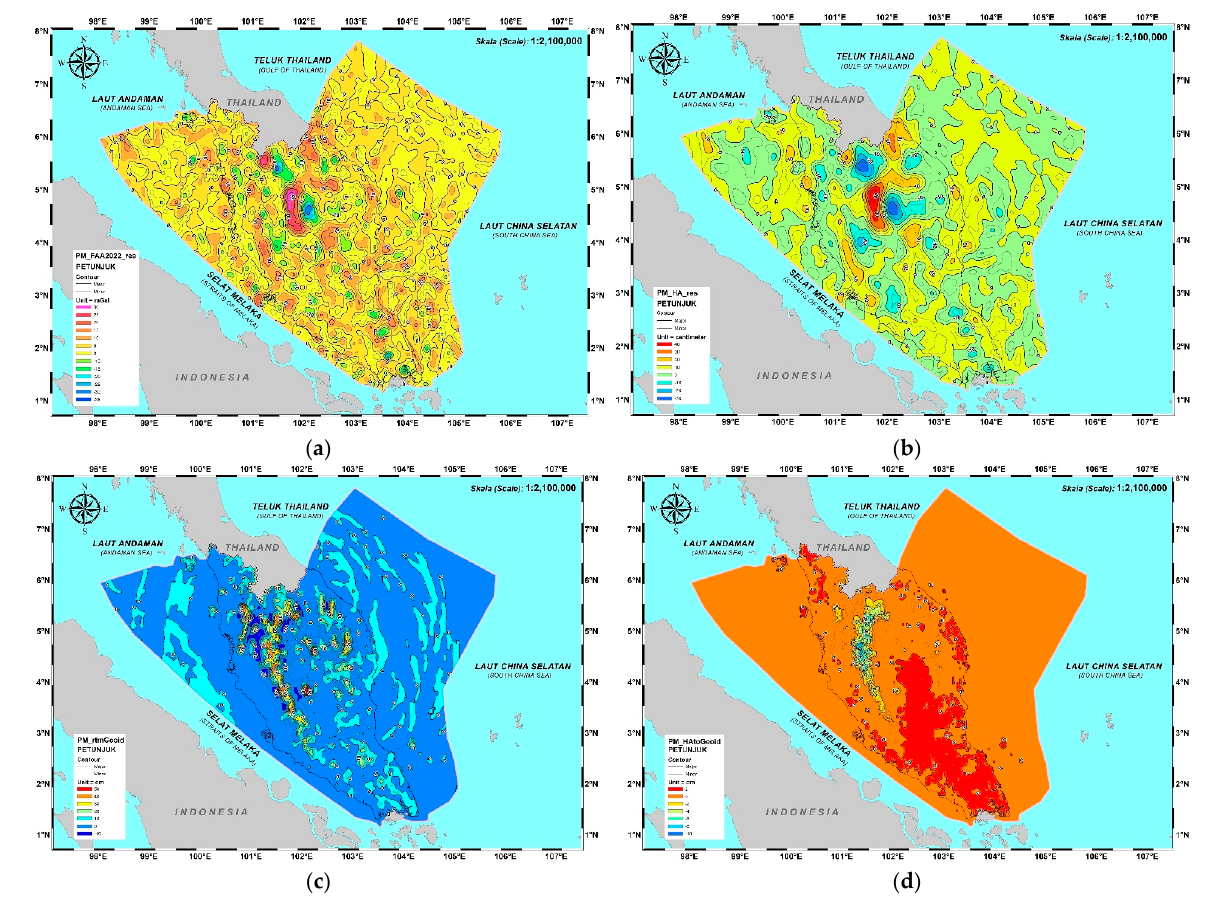
Figure 12. ( a ) Gridded downward continued residual of free-air anomalies, where the contour interval (CI) is 5 mGal; ( b ) Gridded residual height anomalies (CI = 10 cm); ( c ) Gridded geoid RTM correction (CI = 2 cm); ( d ) Gridded co-geoid to geoid correction (CI = 2 cm). Table 10. Fit of older GPS/levelling data to the airborne-only geoid and combined geoid (in meters).